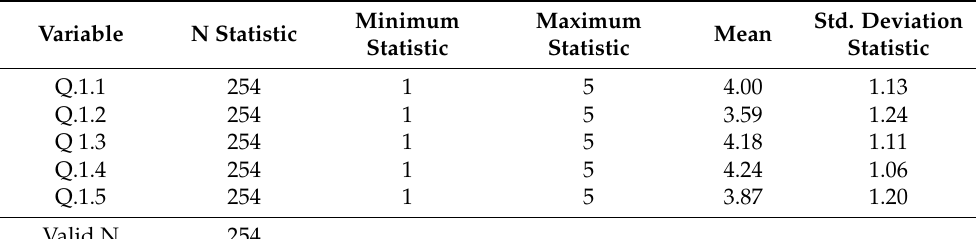
Table 8. Descriptive statistics of individual characteristics.